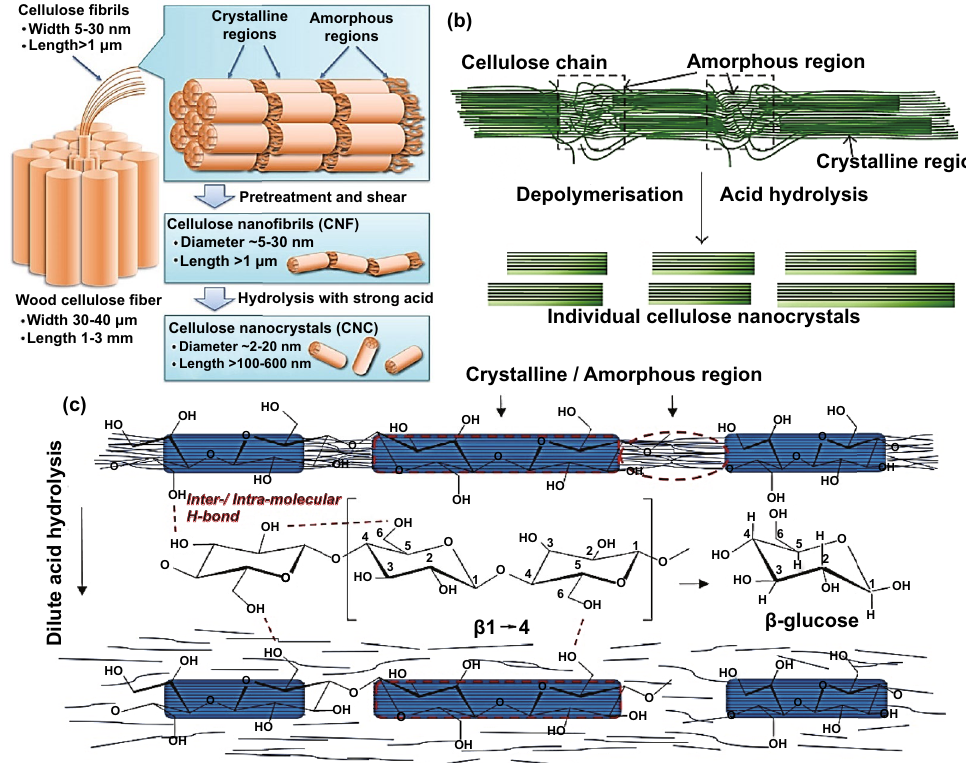
Fig. 2 a Schematic view of nanocellulose obtained from wood via pretreatment and post-treatment of cellulose. Reproduced with permission from Ref. [49] Copyright © 2016, American Chemical Society. b The representation of depolymerization of cellulose to nanocellulose. Repro- duced with permission from Ref. [168] Copyright © 2014, Hindawi Publishing Corporation. c Schematic view of top-down acid hydrolysis of cellulose to separate crystalline regions from non-crystalline regions under the effect of intra-intermolecular hydrogen bonding. Reproduced with permission from Ref. [46] Copyright © 2015,